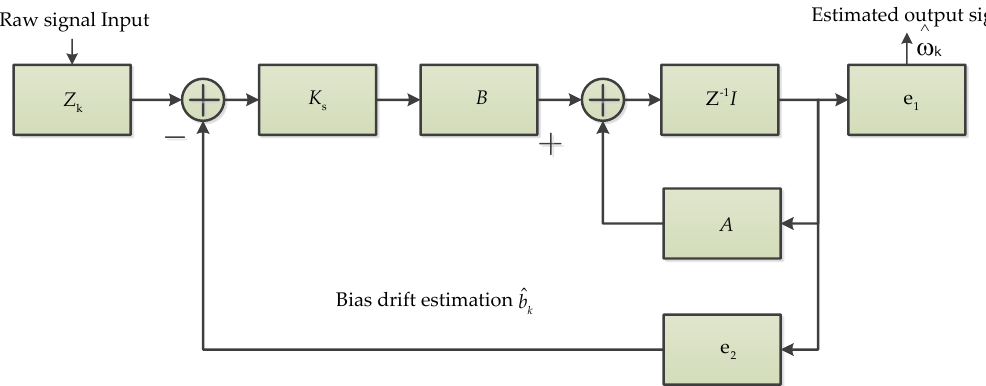
Figure 7. The discrete time Kalman filter for real angular rate signal and bias drift estimation [46].